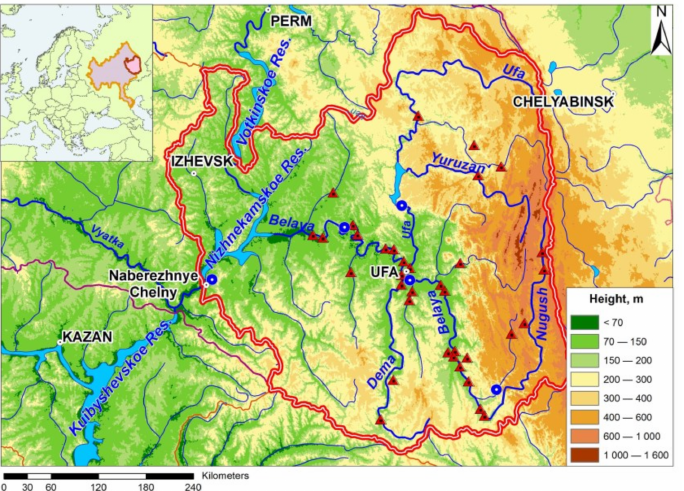
Figure 1. Map of the Nizhnekamskoe Reservoir (NKR) watershed and location of monitoring posts: Hydrological gauges (circles) and hydrochemical monitoring points (triangles). The inset shows the location of the NKR watershed (pink) in the Volga basin (gray) and Eurasian